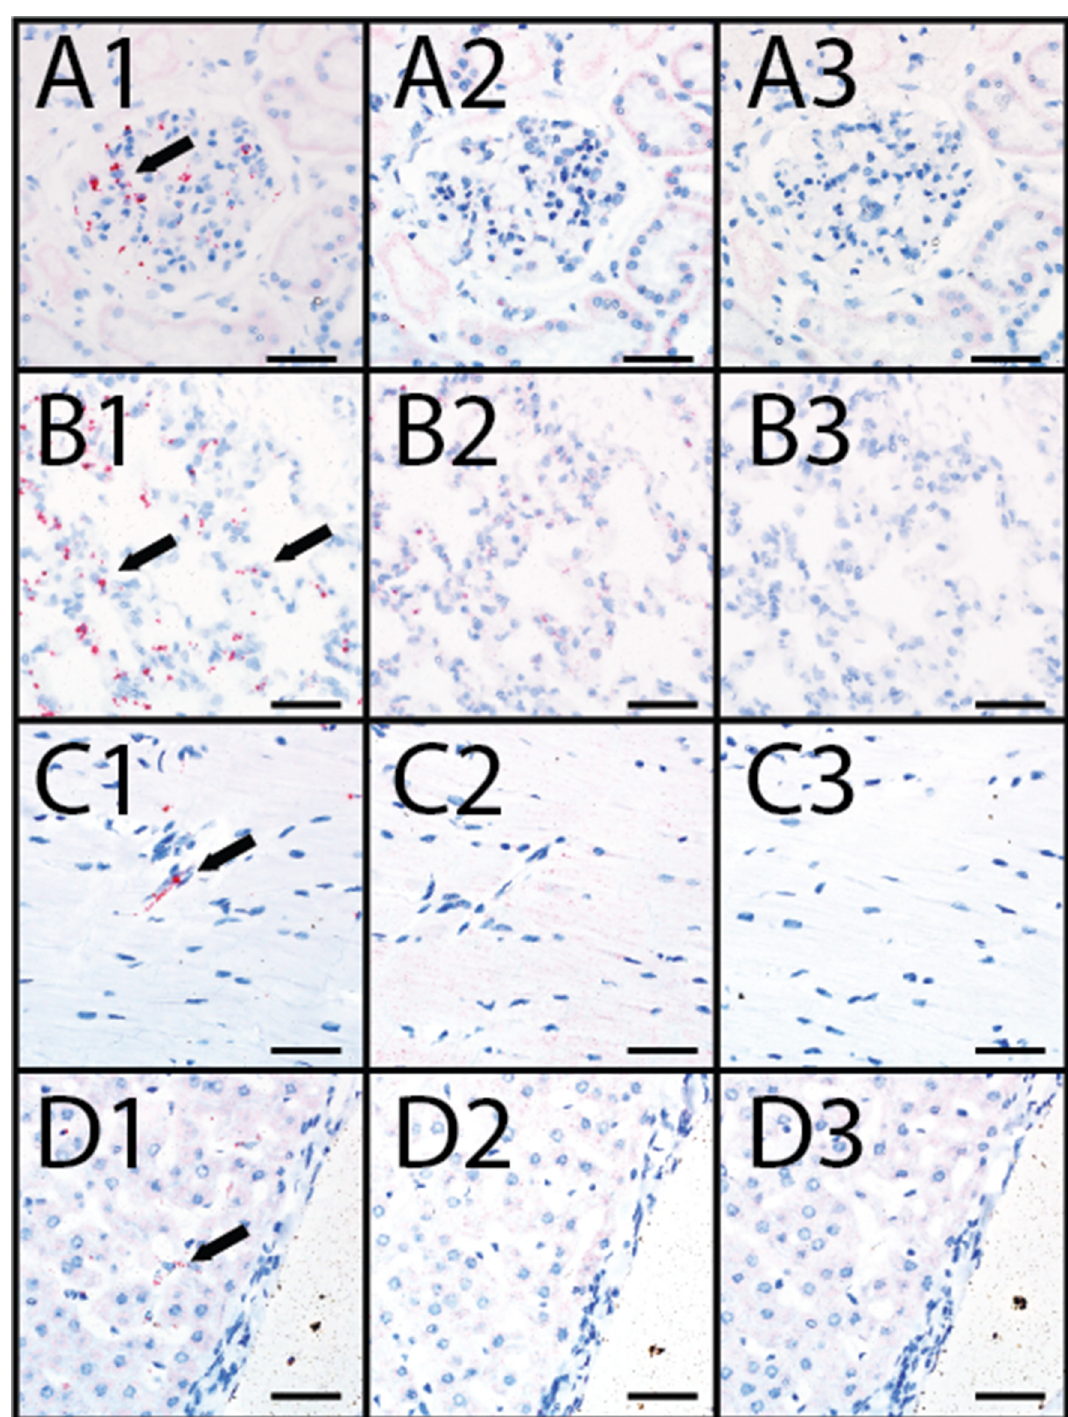
Figure 3. RNAscope ® in situ hybridization (ISH) in farmed deer naturally infected with the U.S. novel reassortant EHDV-6 strain. ( A1 ) OV1248, kidney processed with the EHDV probe: positive EHDV nucleic acid red labeling (black arrow) within endothelium of the glomerulus; ( A2 ) OV1248, kidney processed with the WTD cytB internal positive control probe: positive red labeling is evident in renal interstitial cells; ( A3 ) OV1248, kidney processed with the dapB negative control probe: no red labeling detected; ( B1 ) OV1248, lung processed with the EHDV probe: positive EHDV nucleic acid red labeling (black arrow) detected within pneumocytes and macrophages; ( B2 ) OV1248, lung processed with the WTD cytB positive control probe: positive red labeling detected in pulmonary interstitial cells; ( B3 ) OV1248, lung processed with the dapB negative control probe: no red labeling detected; ( C1 ) OV1248, heart processed with the EHDV probe: positive EHDV nucleic acid red